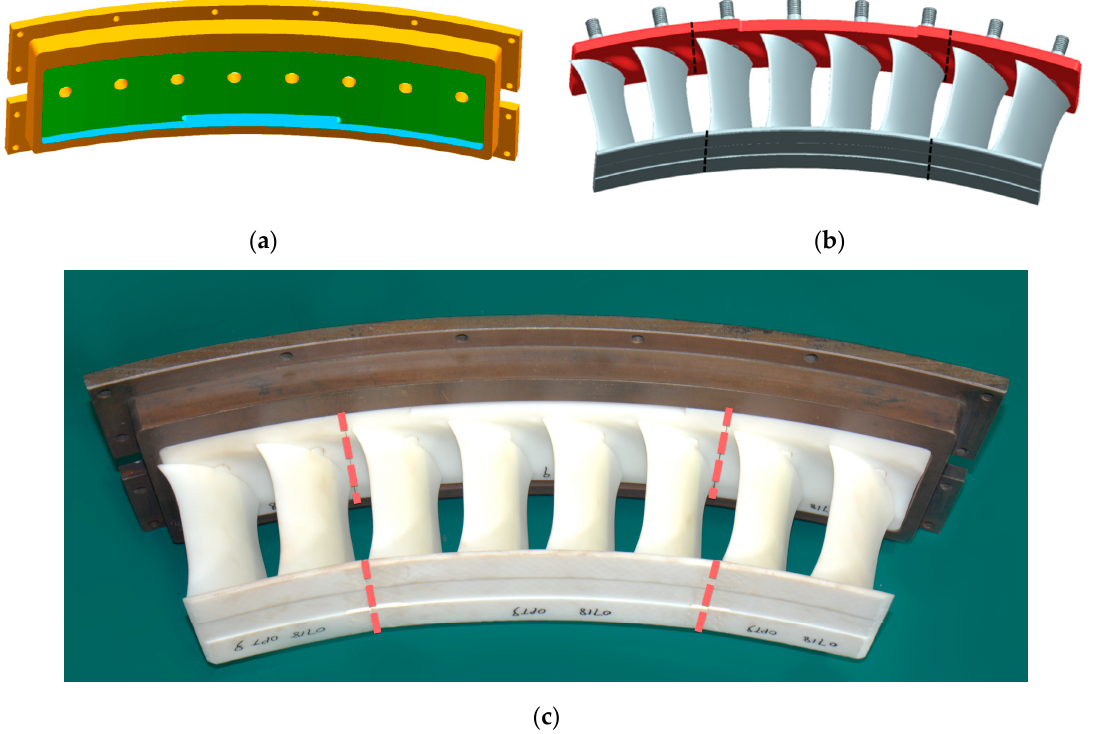
Figure 8. Design of the annular sector cassette. ( a ) CAD model of sector casing with cavity. ( b ) CAD model of blades and Profiled endwall (PEWs). ( c ) Photograph of the annular sector cassette with PEWs and blades.